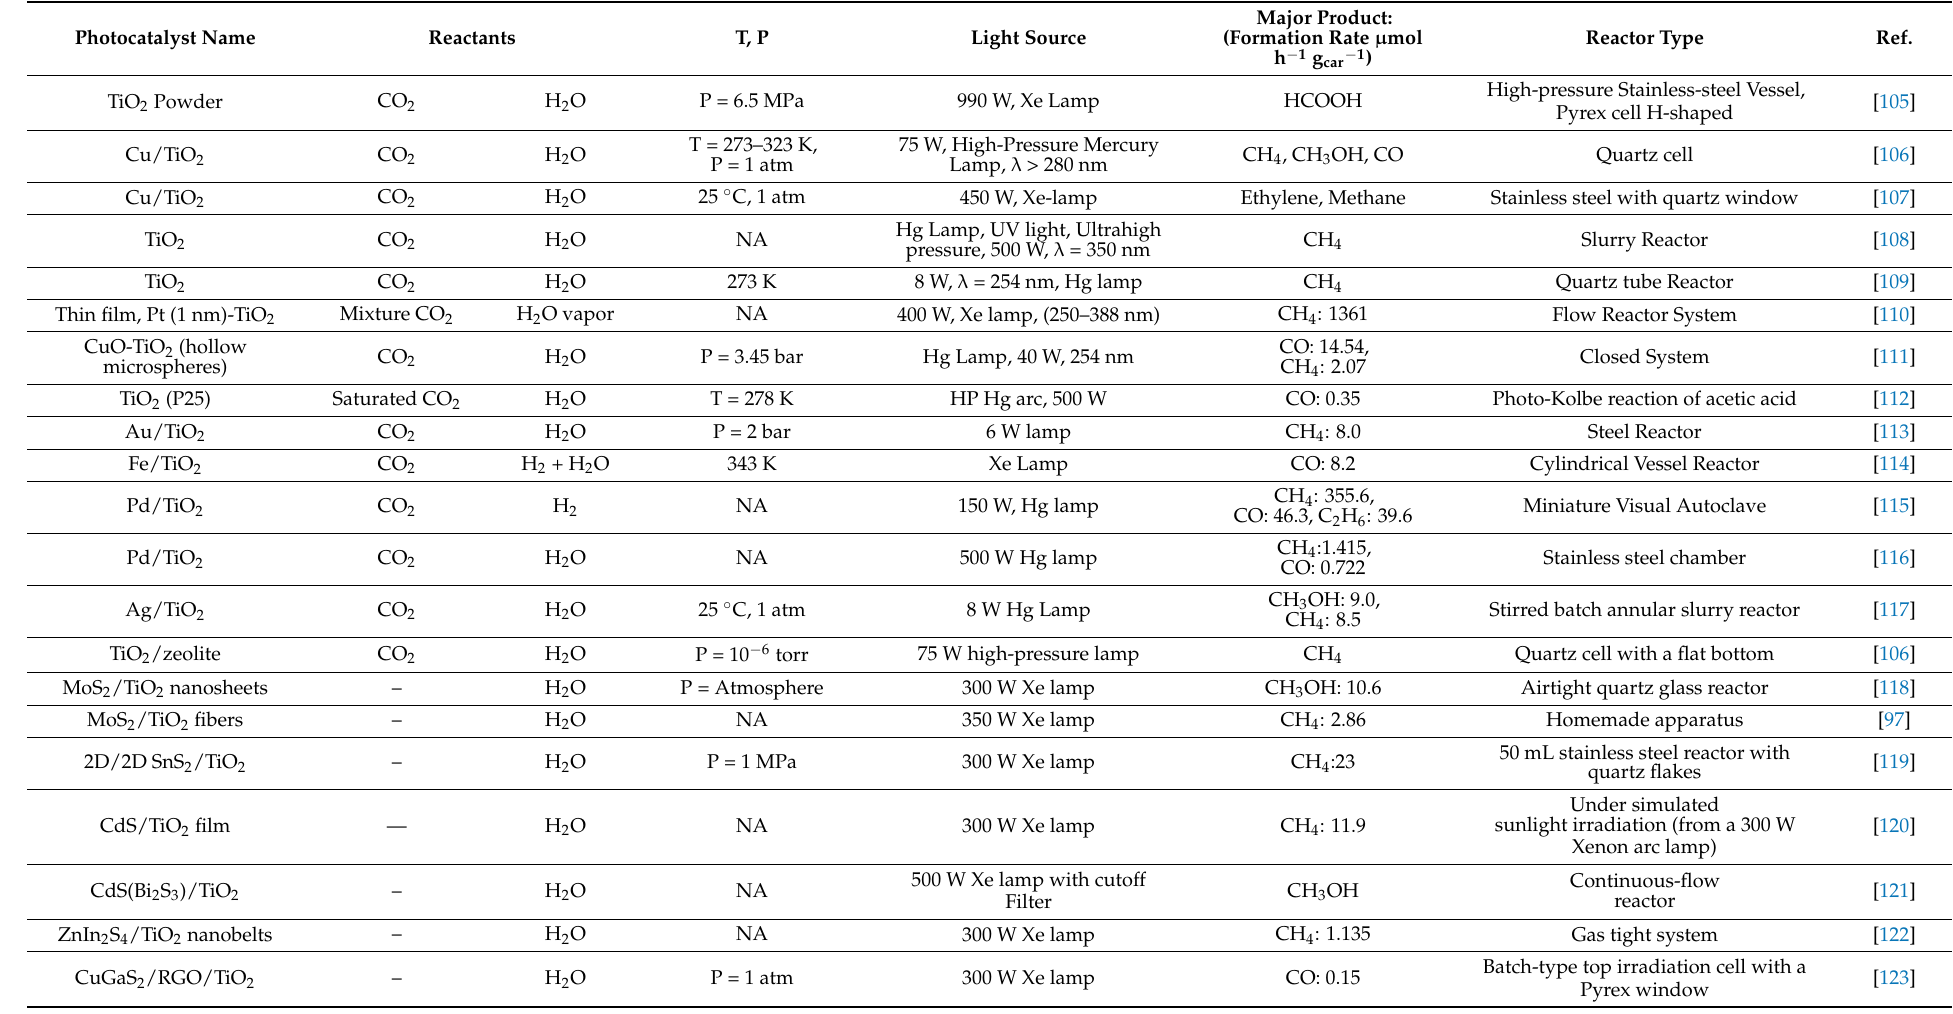
Table 1. Summary of photocatalytic CO 2 reduction literature over various types of TiO 2 -based